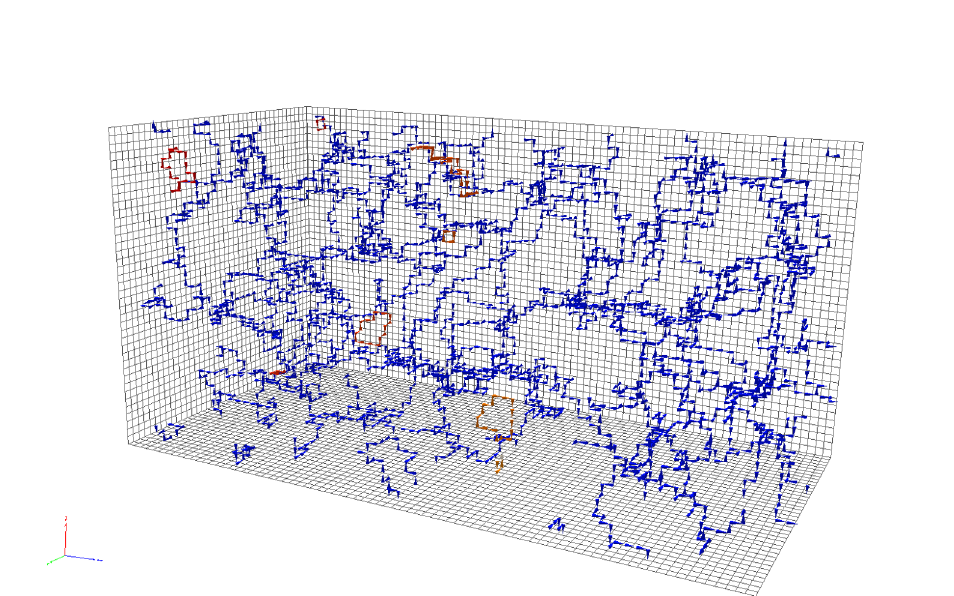
Figure 2. The centre vortex structure of a ground-state vacuum field configuration in pure SU(3) gauge theory. The flow of + 1 centre charge through the gauge field is illustrated by the jets (see main text for a description of the plotting conventions). Here, blue jets are used to illustrate the primary percolating vortex cluster, while other colours illustrate the secondary clusters. ( Click to activate. )